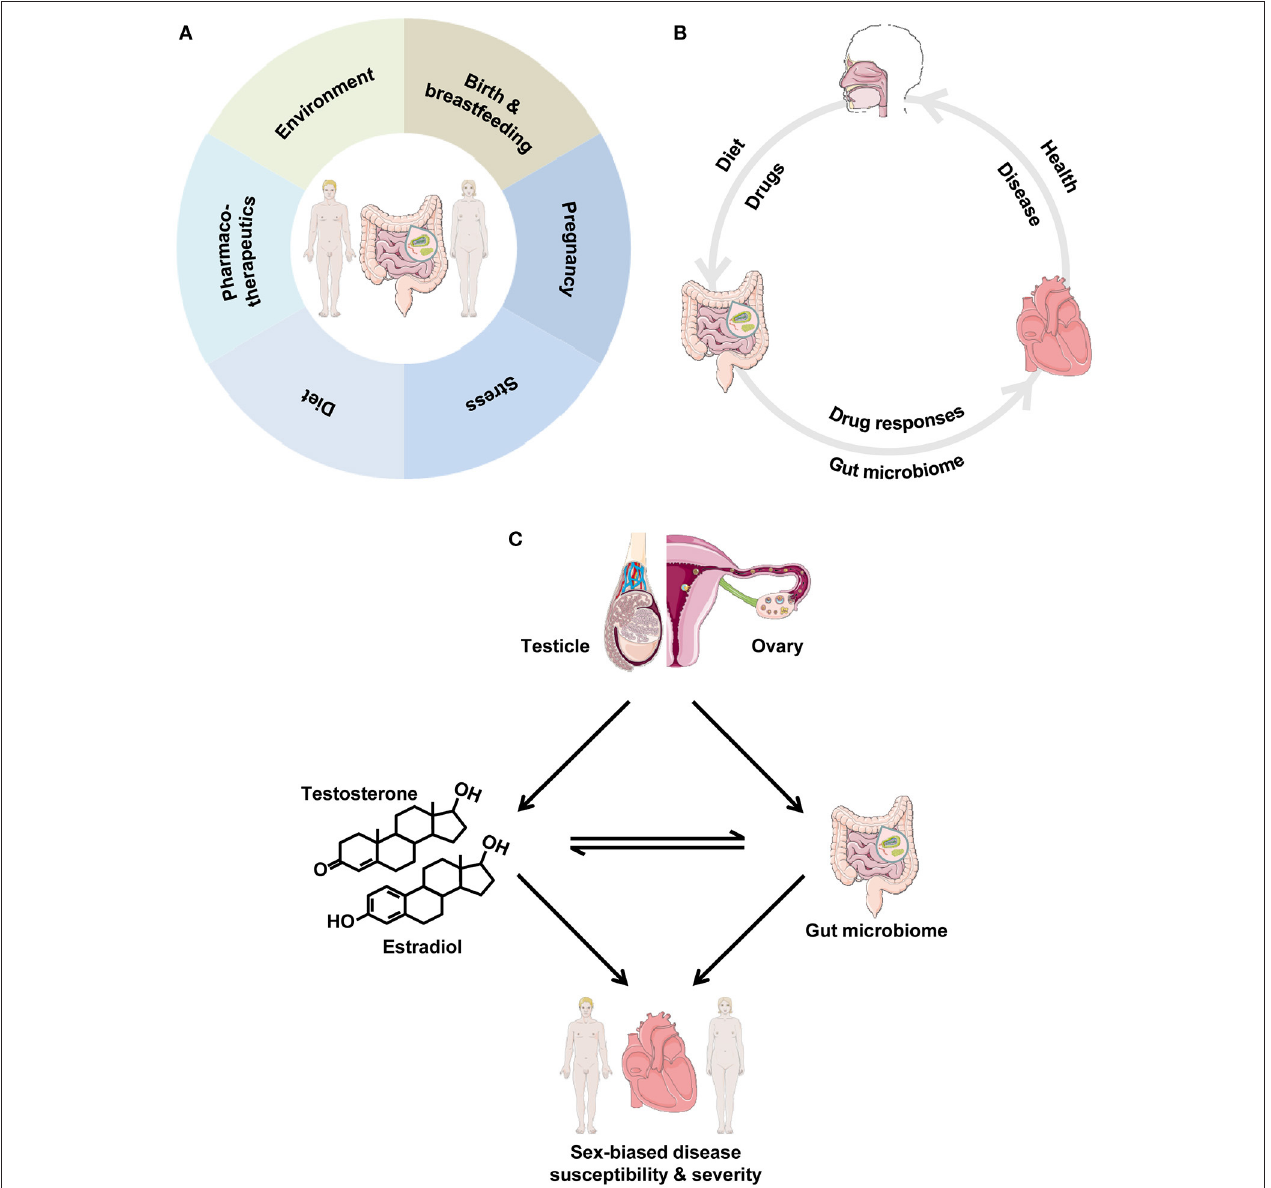
FIGURE 1 | (A) Factors impacting the gut microbiome in a sex-specific manner. The depicted factors can lead to marked differences between men and women in the intestinal microbial community. (B) The gut microbiome and the cardiovascular system. Dietary and other factors impact the gut microbiome, which, in turn, influences cardiovascular health. In disease, drugs elicit responses in the gut microbiome, which, in turn, influences the progression of cardiovascular disease. (C) Interrelationships between biological sex, gut microbiota and the cardiovascular system. We propose the cardiovascular-gut microbiome-sex axis, where the cross-talk between gut microbiota and sex impacts cardiovascular health and disease. Gonadal sex gives rise to male-female hormones and impacts the gut microbiome. In turn, there is a close, bi-directional interaction between sex hormones and gut microbiota, as they influence each other, thereby leading to sex-biased disease susceptibility and severity, ultimately leading to the observed sex differences in cardiovascular